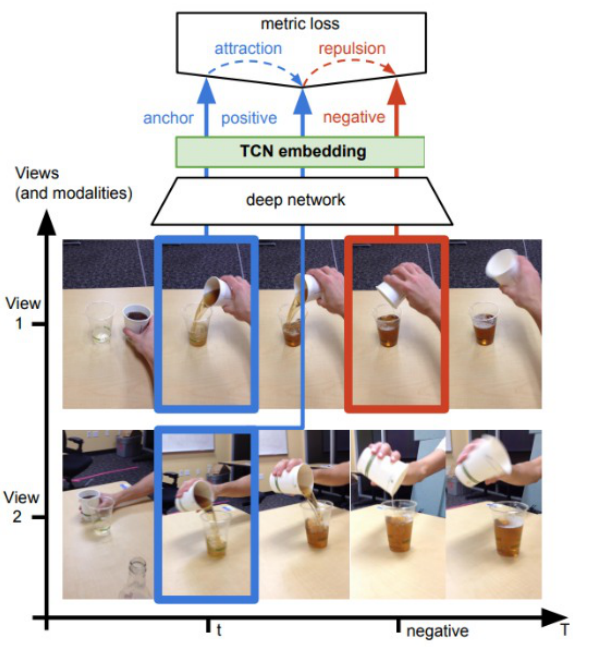
Figure 8. Learning representation from video frame sequence [23].